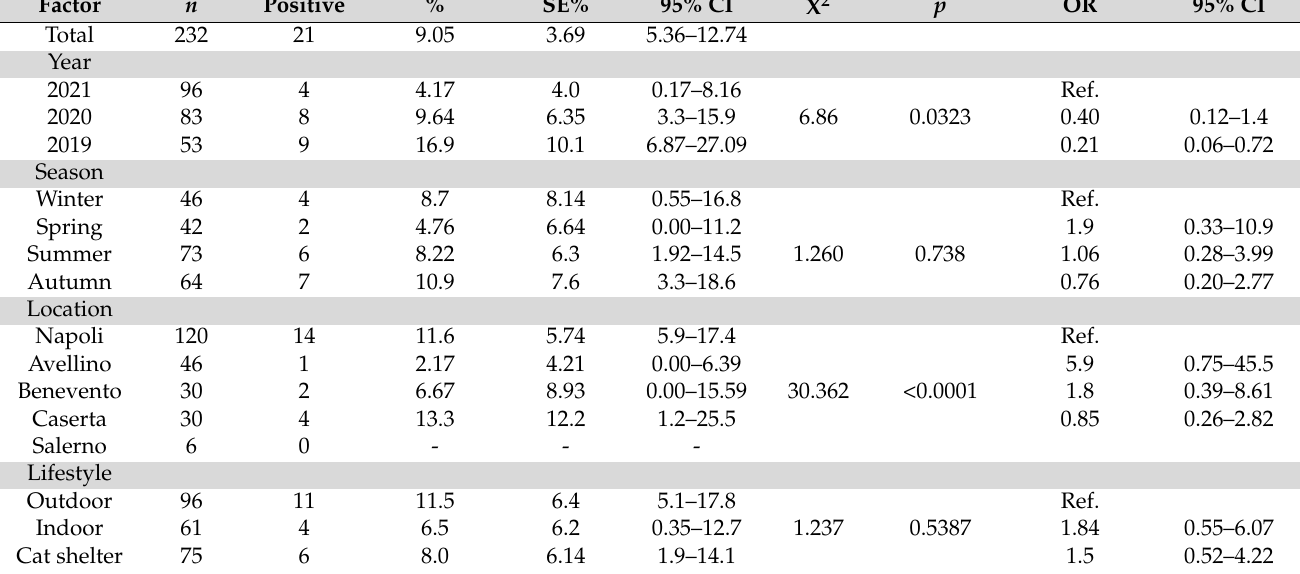
Table 7. FHV-1 prevalence of infection and risk factor analysis (Campania Region, 2019–2022).